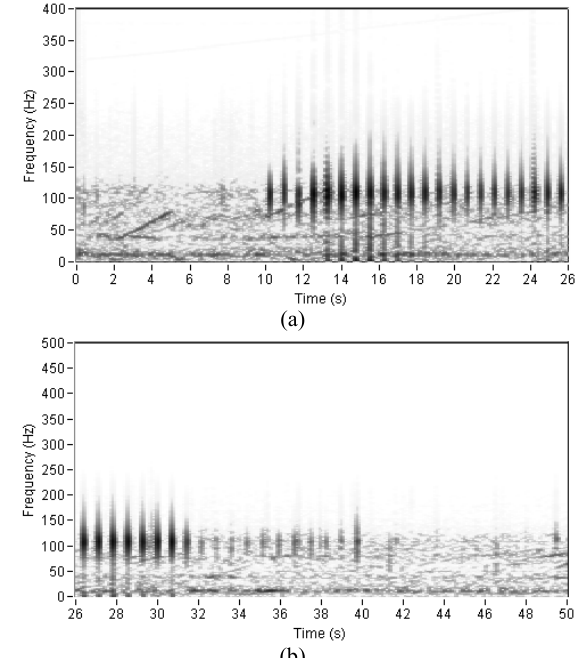
Fig. 8. The spectrogram of the recorded Korotkoff sounds.